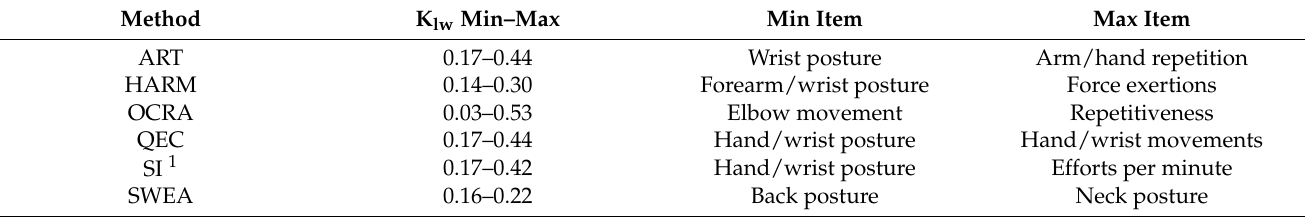
Table 6. The inter-observer reliability, in the linearly weighted Kappa (K lw ), for the items in each method that were rated by the ergonomists (in the first session) from the video-recorded work tasks. The item with the lowest K lw (Min item), and the item with the highest K lw (Max item) refer to the min and max columns.